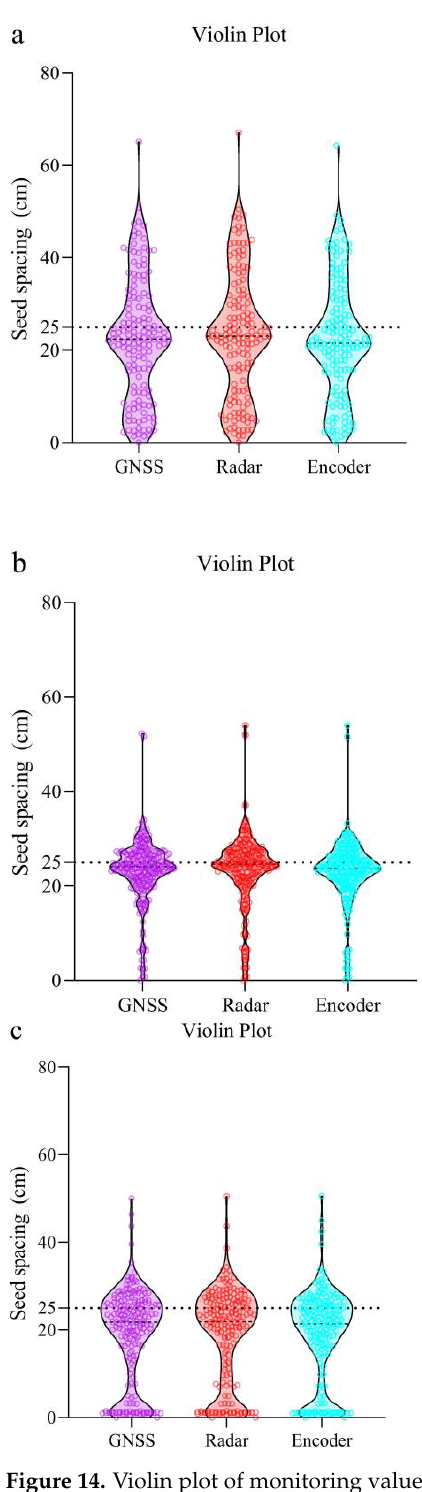
Figure 14. Violin plot of monitoring values of real-time seeding spacing (a, b, and c: three uniform-speed seeding tests).